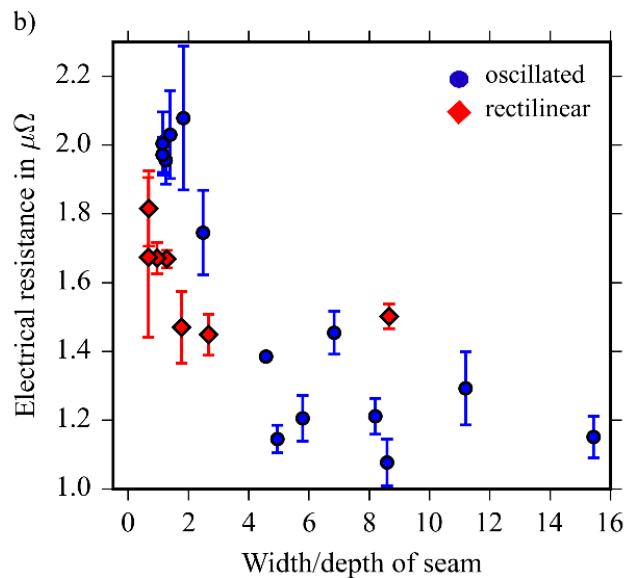
Figure 14. Electrical resistance in dependence on the welding depth into Cu ( a ) and on the ratio of weld seam width to depth ( b ).